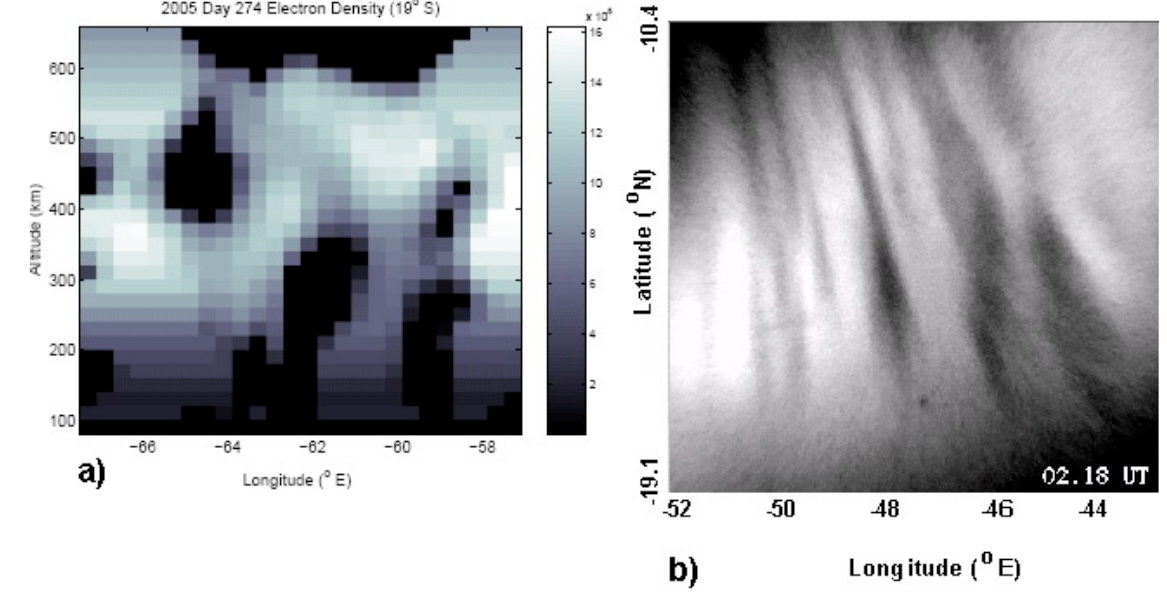
Fig. 4. Comparison of GUVI reconstruction (left) and redline airglow imager (right) for Day 274, 2005.